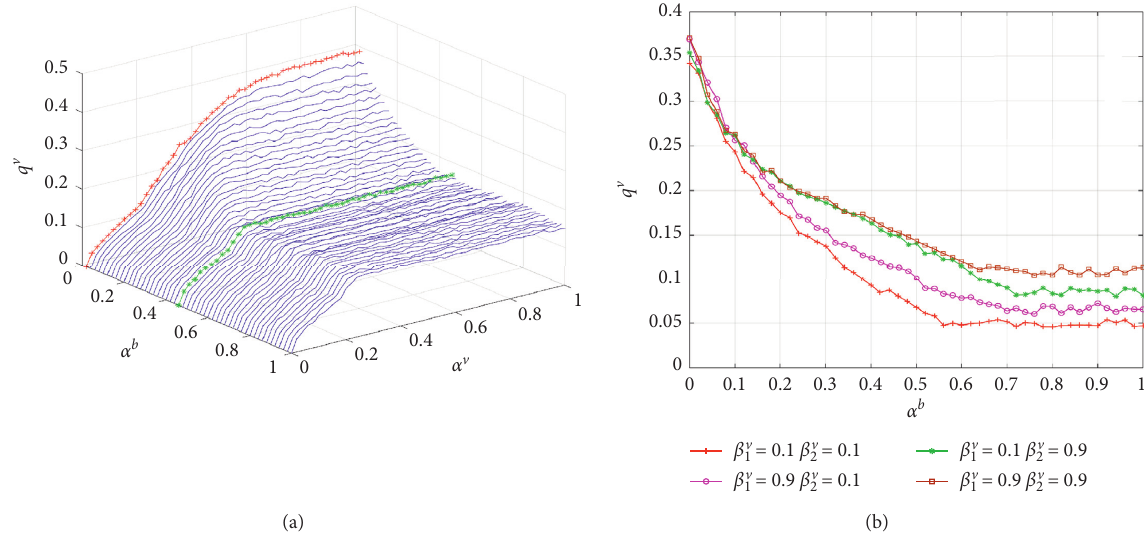
Figure 8: Relationship between vehicle flow and vehicle and bicycle inflow rate under different driving behaviors.